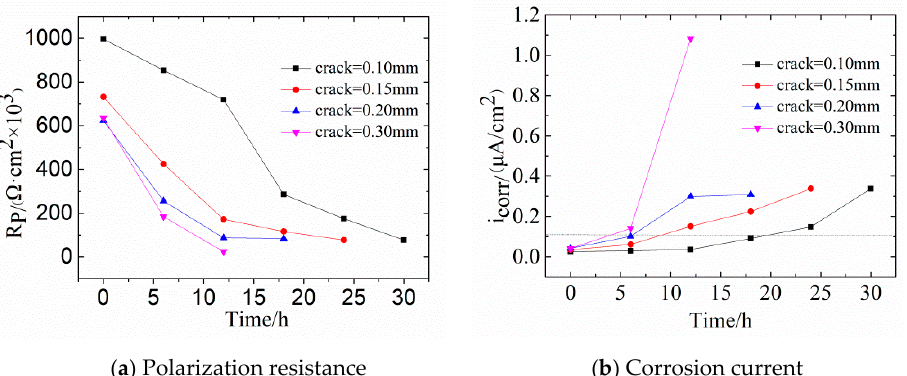
Figure 8. ( a ) Polarization resistance and ( b ) corrosion current density for concrete reinforced with low carbon steel with different crack widths.